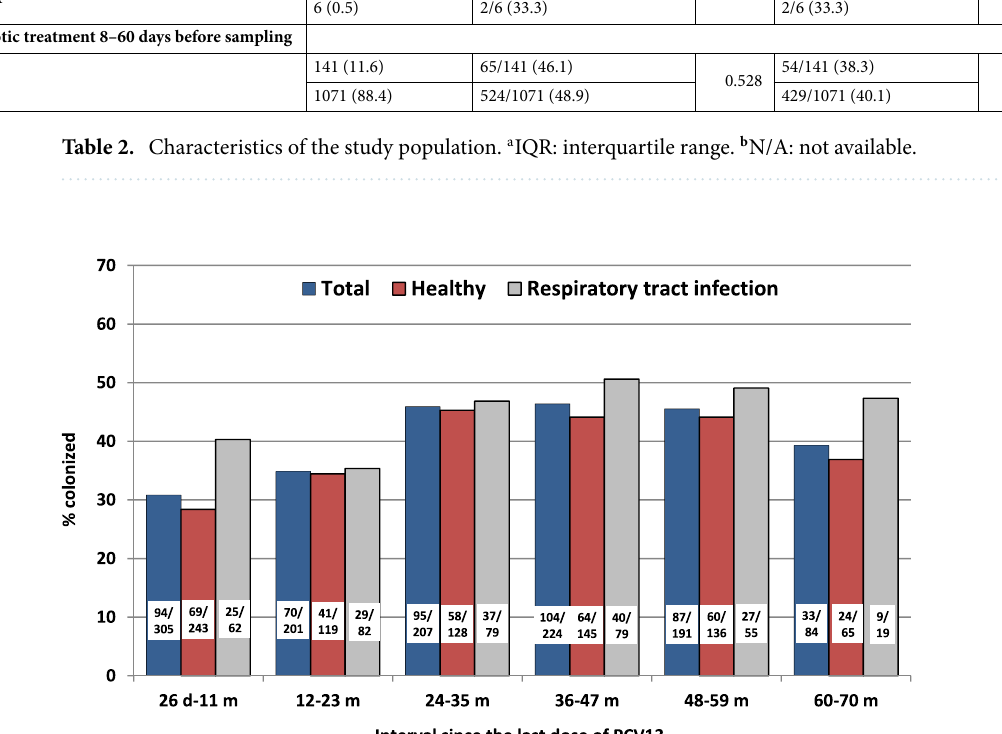
Figure 1. Colonization rate of children with typeable isolates according to increasing interval since the last dose of PCV13 (total, healthy and children with respiratory tract